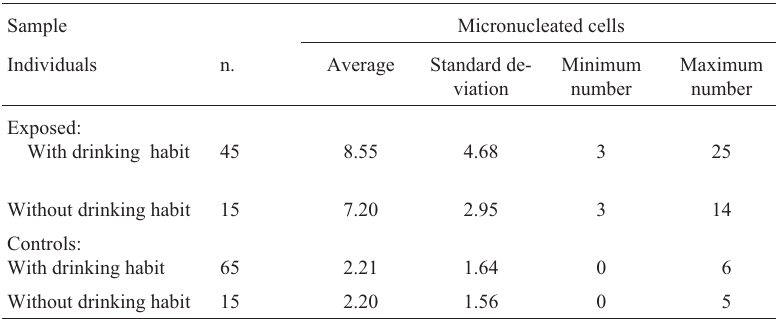
Table IV - Average numbers of micronucleated cells (in 3000 cells analyzed per individual) of the group of individuals exposed to byproducts of petrol and lead, and of controls, with and without drinking